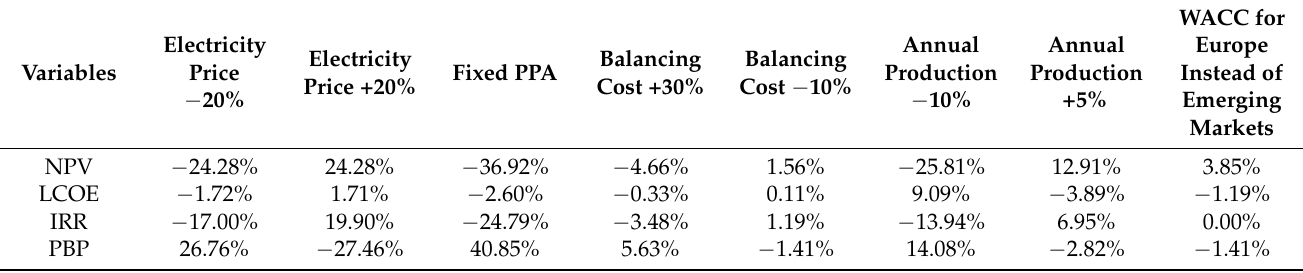
Table 9. Sensitivity analysis of the PV plant financial